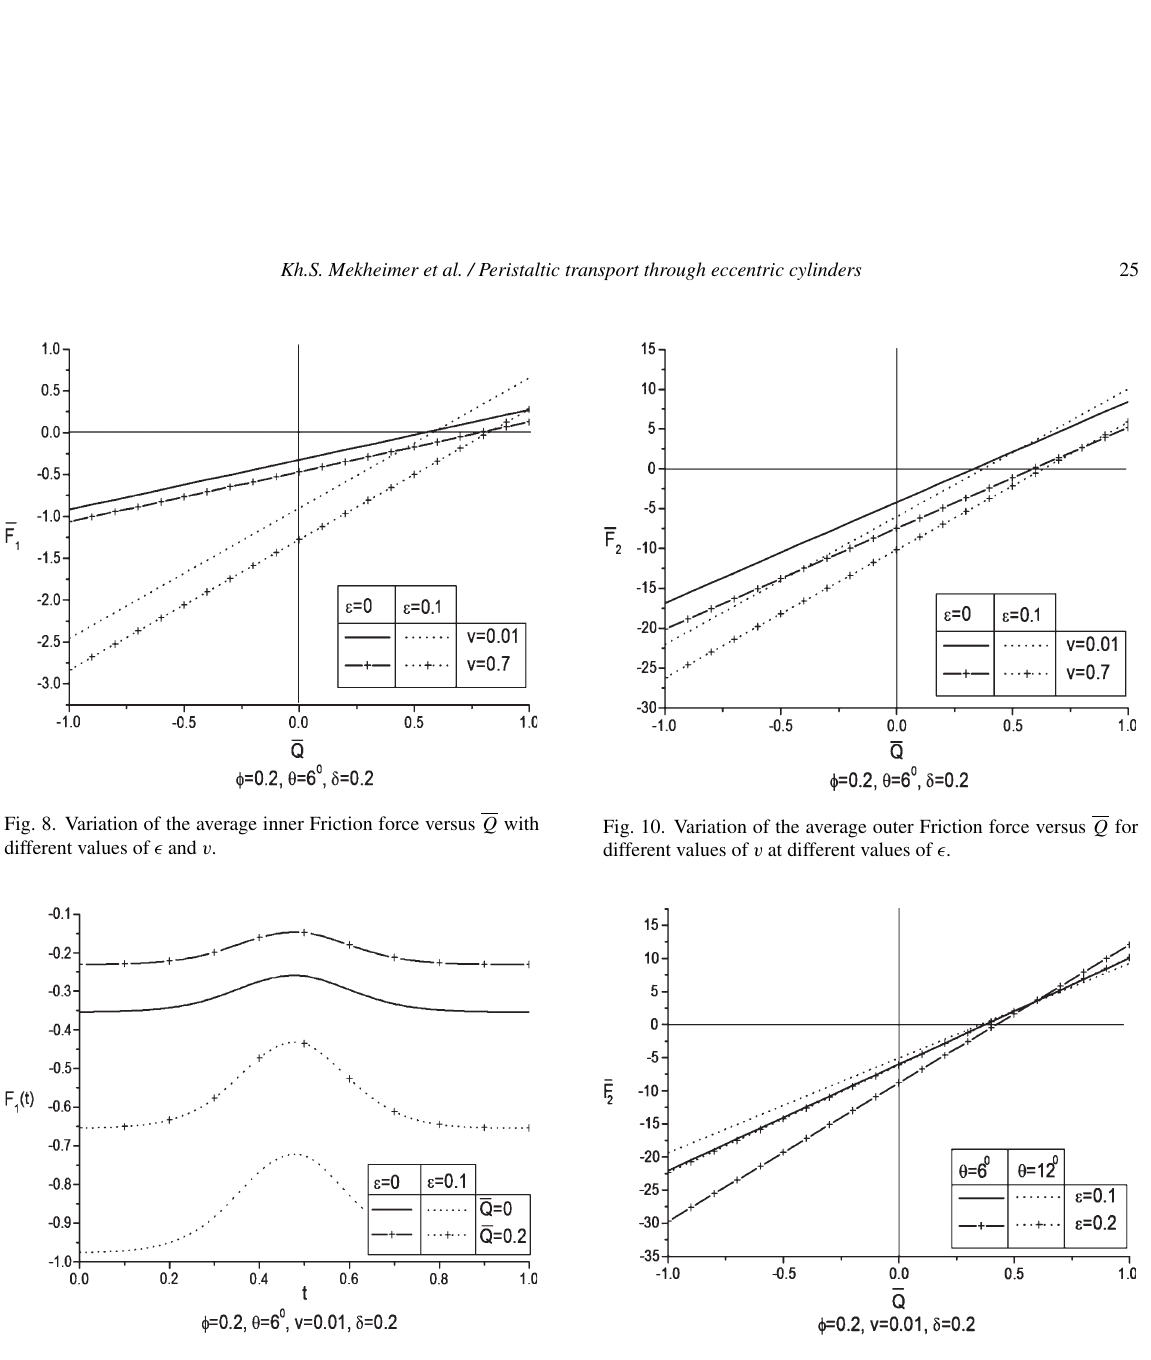
Fig. 11. Variation of outer Friction force versus Q for different values of v at different values of (cid:2) . r and t for different values of different governing